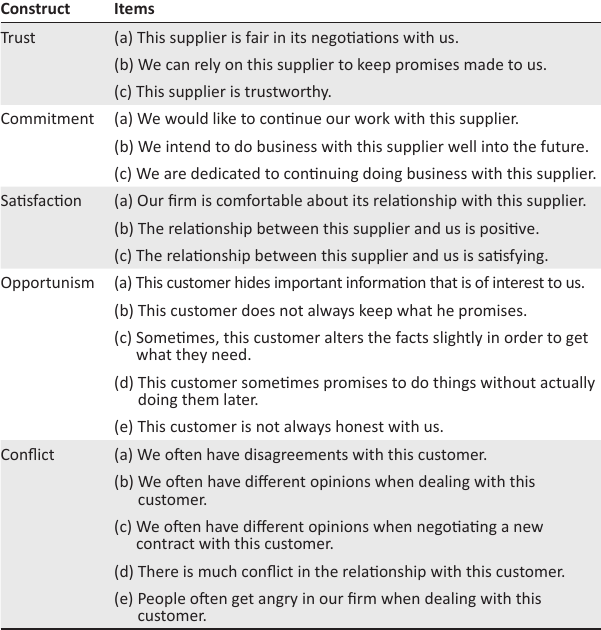
TABLE 1: Scale items: Original study and replication